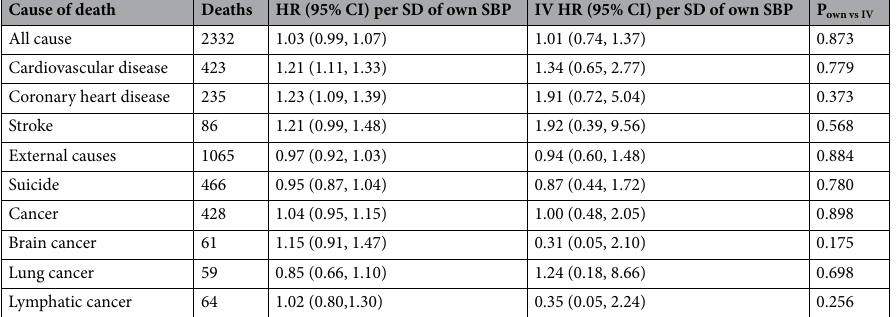
Table 2. Adjusted hazard ratios (HR) for paternal mortality (i) per standard deviation (SD) of own systolic blood pressure (SBP) and (ii) per SD of own SBP, using son’s SBP as an instrumental variable (IV) within the subset having data on own SBP. SBP was pre-adjusted for regional patterns, secular trends and age at examination and its SD was 10.80 mmHg. Cox proportional hazards models with age as the time axis were adjusted for educational and occupational socioeconomic position. One-sample IV estimates were made using the ratio method. P own vs IV was derived from Durbin-Wu-Hausman tests comparing the two HR. N = 66,567 fathers at risk of mortality. Rarer causes of death (< 50 deaths in the data subset) are omitted.